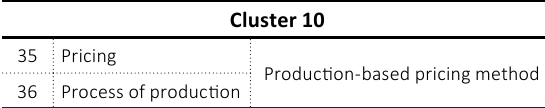
Table 11. Codes comprising Cluster